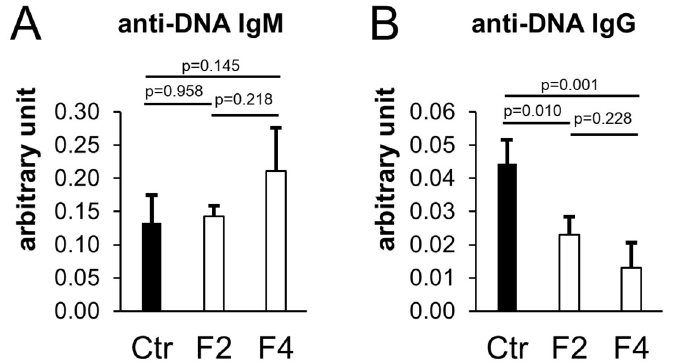
Fig 3. Intergenerational effects of T . halophilus No. 1 on the serum levels of anti-DNA Ig. Anti-DNA IgM and IgG serum levels were assessed. Mice (n = 4) were fed diets with or without 1% T . halophilus No. 1 until they were 16 weeks of age. Then, serum samples were obtained and analyzed. The F2 generation data were used for the control. (A) Anti- DNA IgM levels in the serum. (B) Anti-DNA IgG levels in the serum. Bars indicate mean ± SD. Based on the Tukey– Kramer test, P-value was found to be relative to the